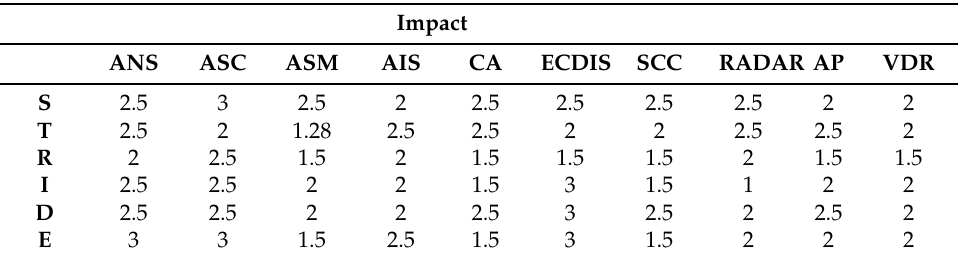
Table 2. Impact values.